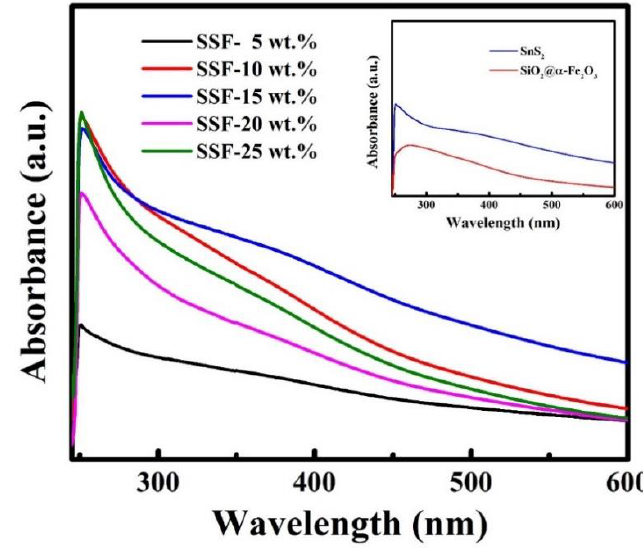
Figure 6. UV – Visible diffused reflectance spectra (DRS) spectra of as-synthesized SSF-X (X = 5, 10, 15, 20, 25 wt %); the inset shows DRS spectra of SnS 2 and SiO 2 @ α -Fe 2 O 3.